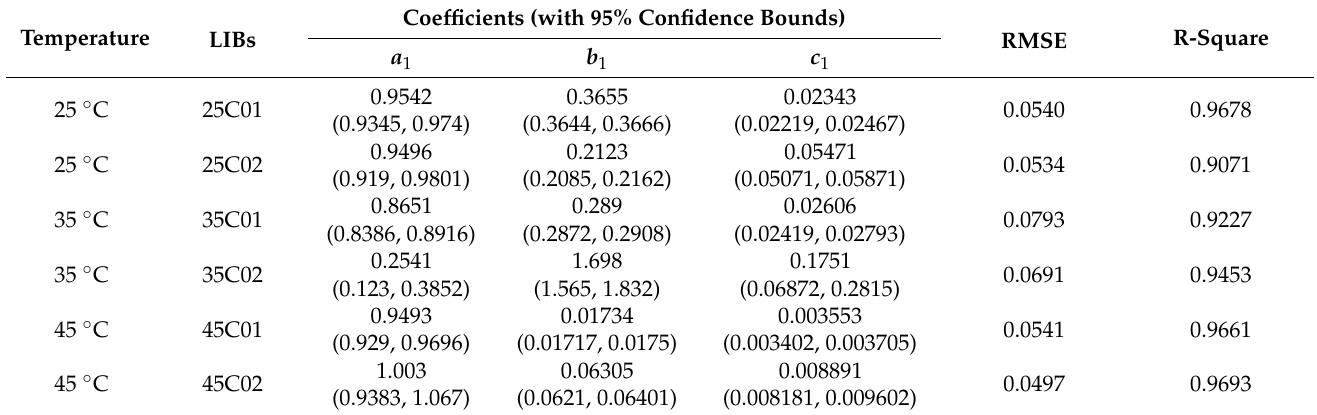
Table 5. Model fitting results under different